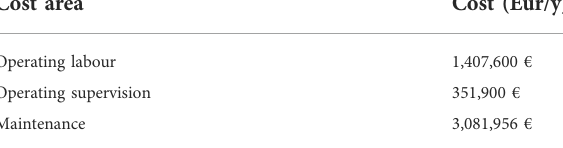
TABLE 6 Material costs for the process in 2021 Euros (Hanaoka et al., 2015; Collis et al., 2021; Zauba; Broker, 2022). Off-gases from the process are re-sold to the steel mill for heat and electricity generation.